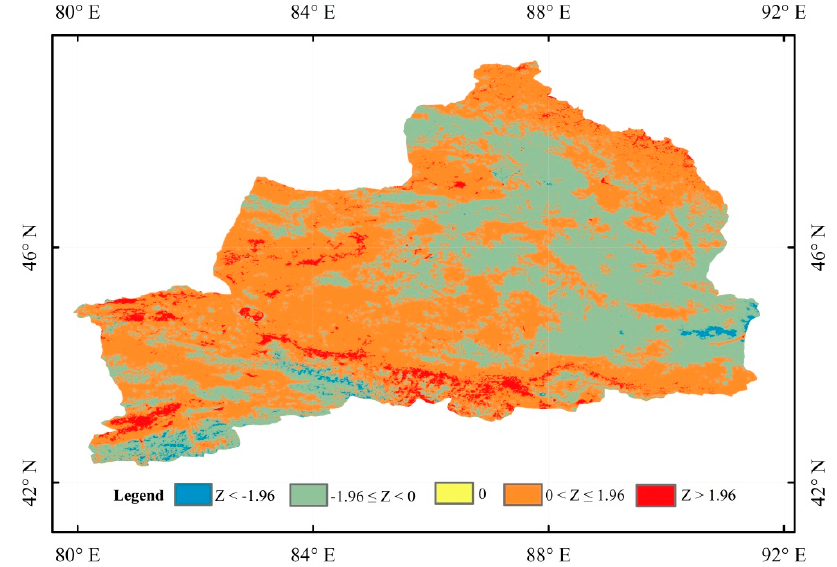
Figure 9. Significance of the SCD variation in northern Xinjiang, China based on the Mann–Kendall method from 2001 to 2018.